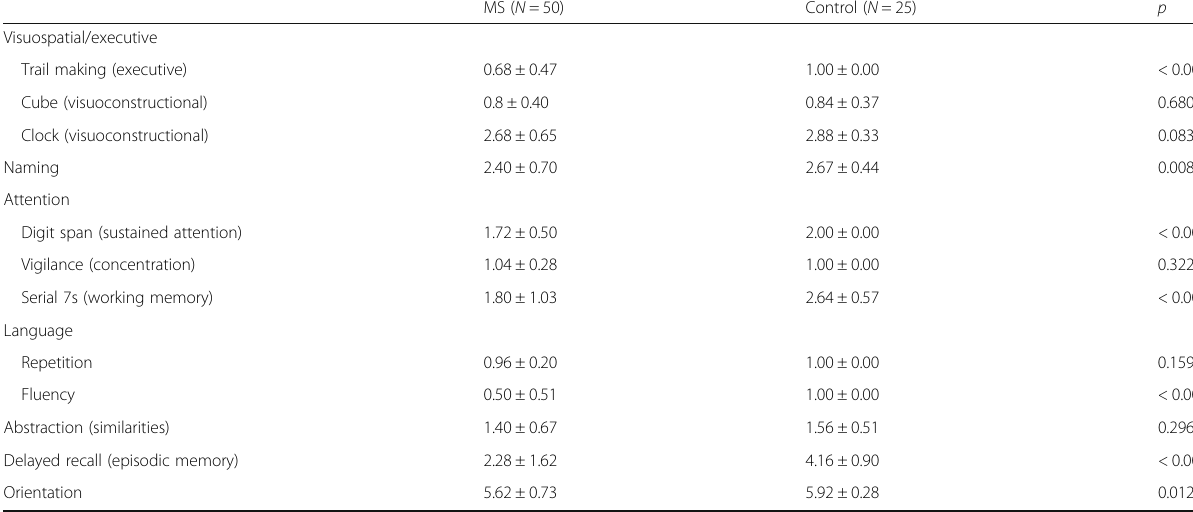
Table 3 Montreal cognitive assessment in MS and control MS ( N =50) Control ( N =25)